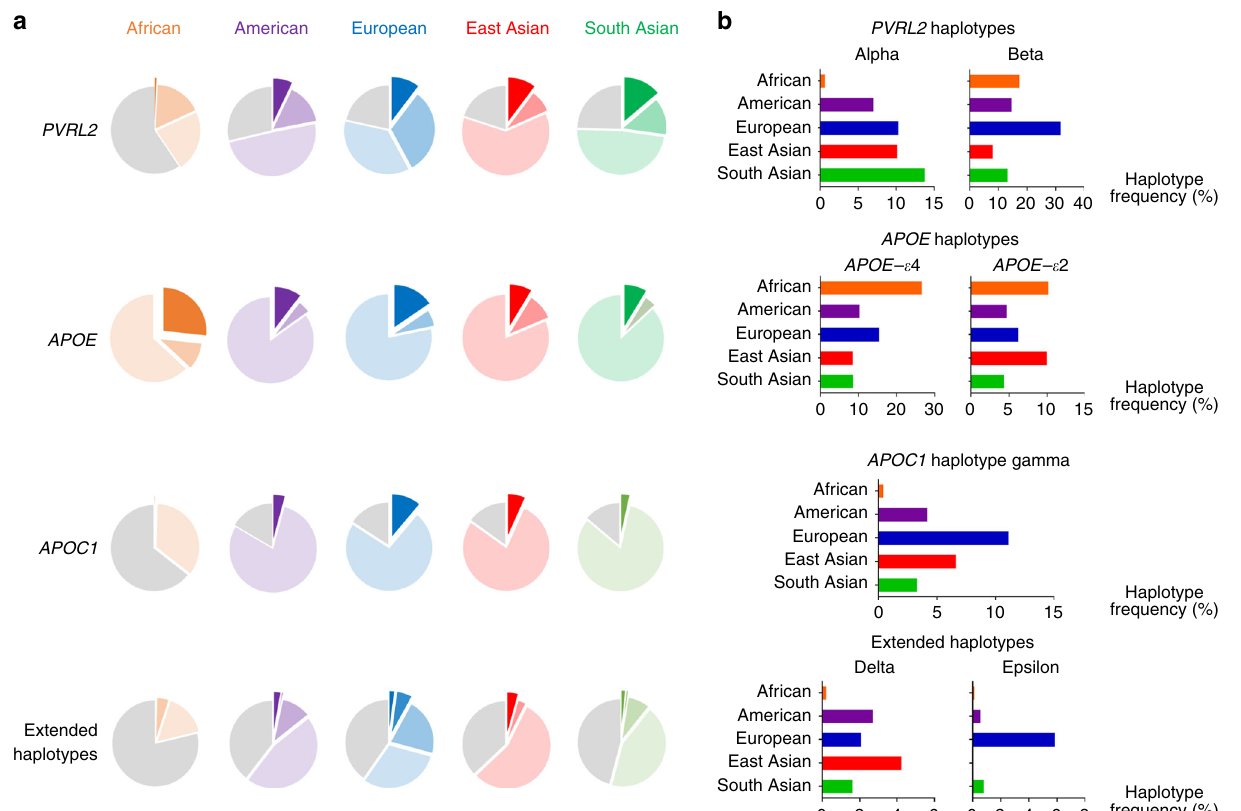
Fig. 7 Heterogeneity of the prevalence of risk haplotypes in APOE and the surrounding region among populations. Data were derived from the 1000 Genomes phase 3 whole-genome sequencing dataset ( n = 2504, comprising 661 African, 347 American, 503 European, 504 East Asian, and 489 South Asian genomes). a Major and minor haplotypes among populations. The proportions of minor haplotypes are shown as exploded areas in dark colors; areas with light colors denote the proportions of major haplotypes (i.e., the most frequent ones), and gray areas indicate the proportions of all other haplotypes for the corresponding locus. Exploded areas denote the phenotype-associated minor haplotypes for comparison across ethnic groups, with detailed frequencies shown in the right panel. b Frequencies of minor haplotypes across different ethnic groups, with the x -axis denoting the haplotype frequencies across